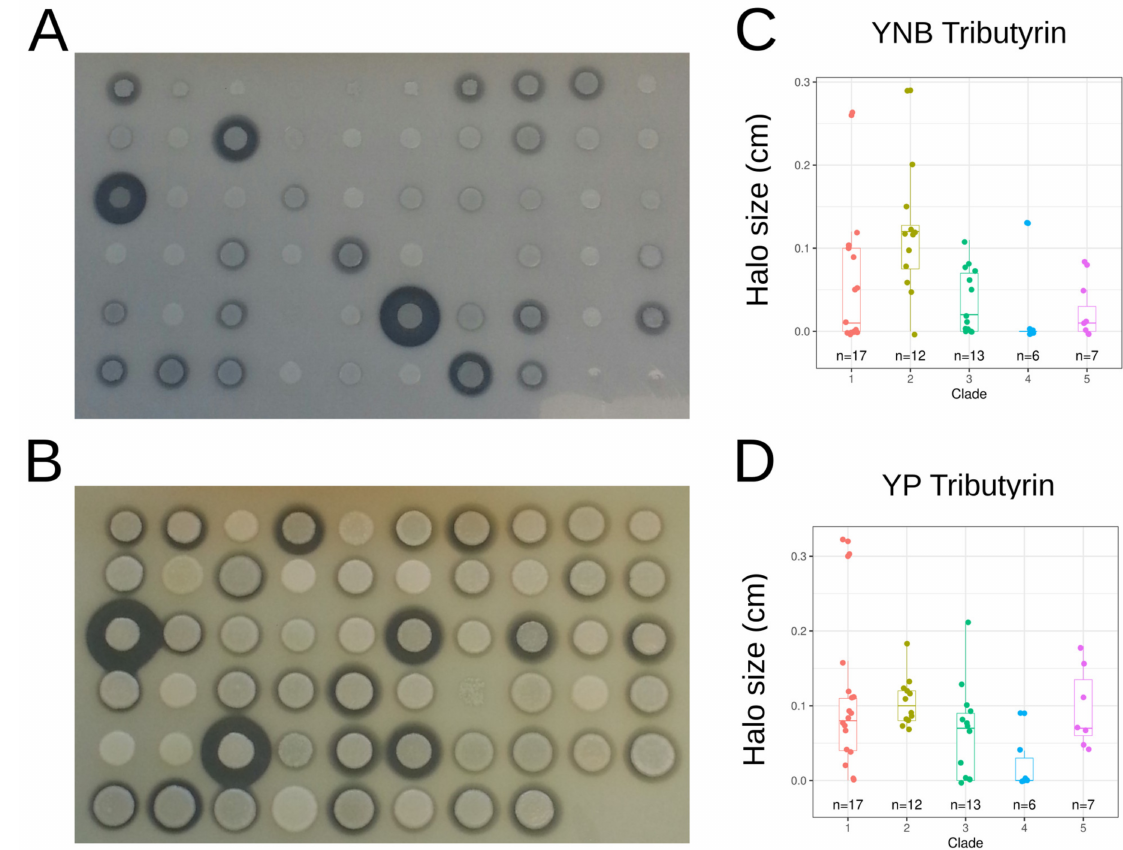
Figure 5. Lipase activity on tributyrin. ( A ) halo formation around colonies grown on media containing tributyrin and YNB, ( B ) halo size as a function of the clade as obtained on the YNB media, ( C ) halo formation around colonies grown on media containing tributyrin and YP, ( D ) halo size as a function of the clade as obtained on the YP